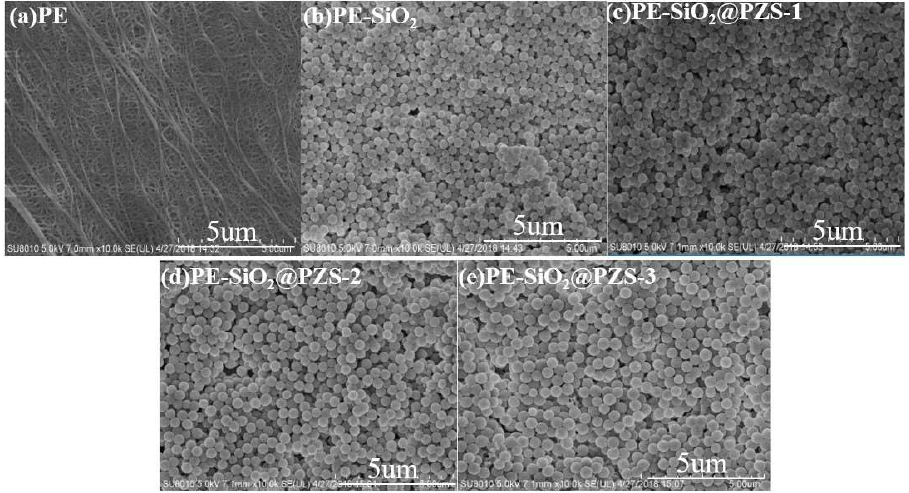
Figure 3 . Surface morphologies of ( a ) PE membrane, ( b ) PE-SiO 2 , ( c ) PE-SiO 2 @PZS−1, ( d ) PE-SiO 2 @PZS−2 and ( e ) PE-SiO 2 @PZS−3 separators.